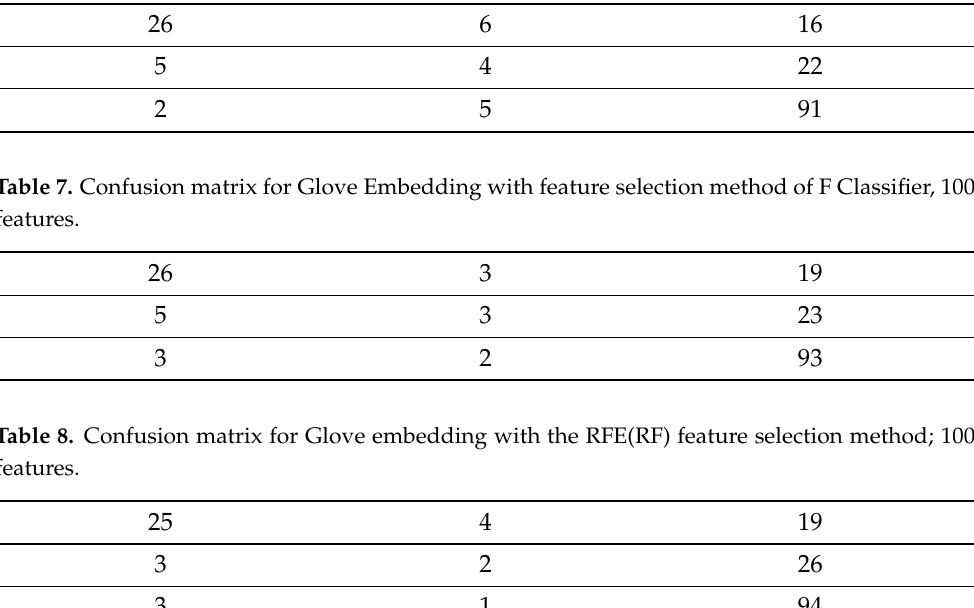
Table 6. Confusion matrix for Glove embedding with the RFE(RF) feature selection method; 50 features.